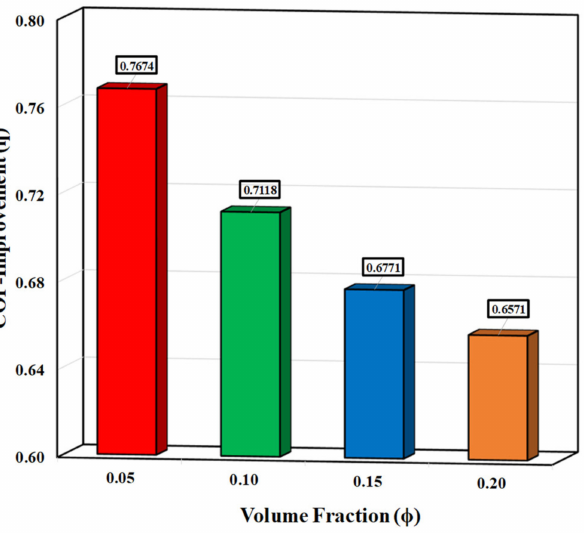
Figure 14. COP improvement of Ag–MgO/water hybrid nanofluid with different volume fractions at Re = 3200.